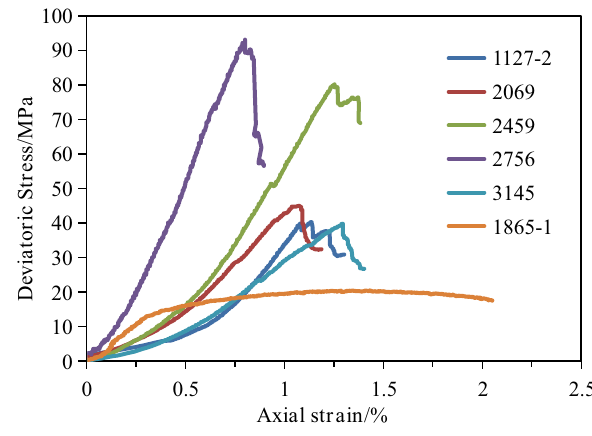
Fig. 2 Stress–strain curves of different samples under uniaxial com- pression